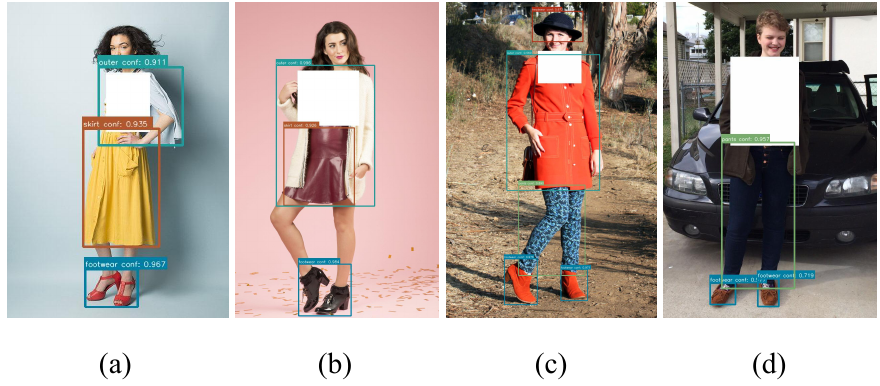
Figure 3. Some results from YOLOv3 (pre-trained on ModaNet) on the Street2Shop dataset, where the predicted item is masked with a white image. In each image, the detected object is annotated with a bounding box, the predicted category and a probability score. Example ( a , b ) have a single-color background while ( c , d ) have a complex background.